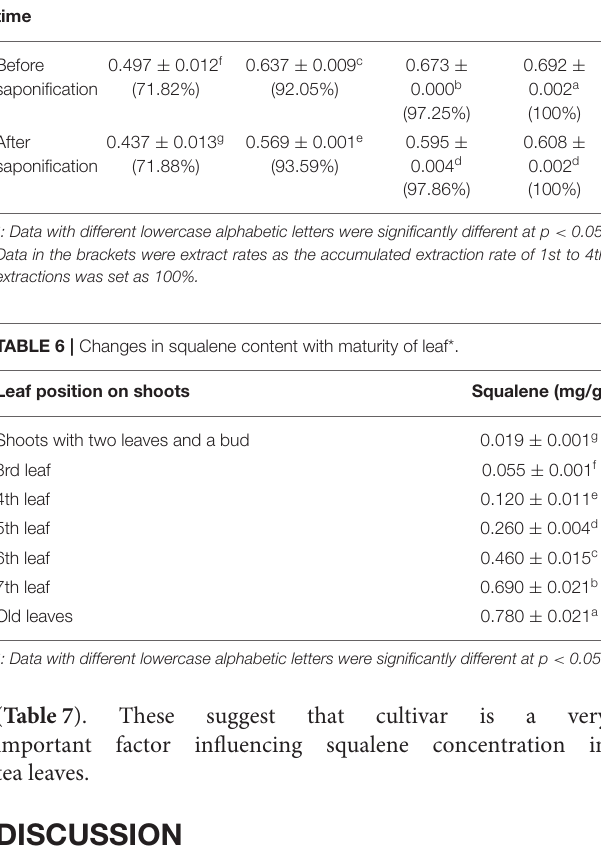
TABLE 5 | Accumulated content of squalene with extraction times (mg/g)*. Extraction time